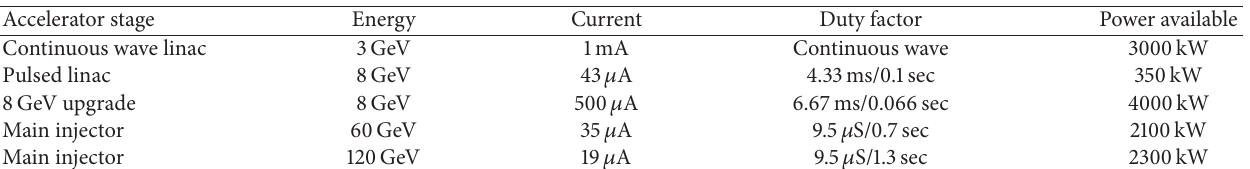
Table 3: Beam conditions and power possible during the Project-X phase and further upgrades to the 8GeV performance. An accumulator ring at 8 GeV could be used to improve the duty factor.